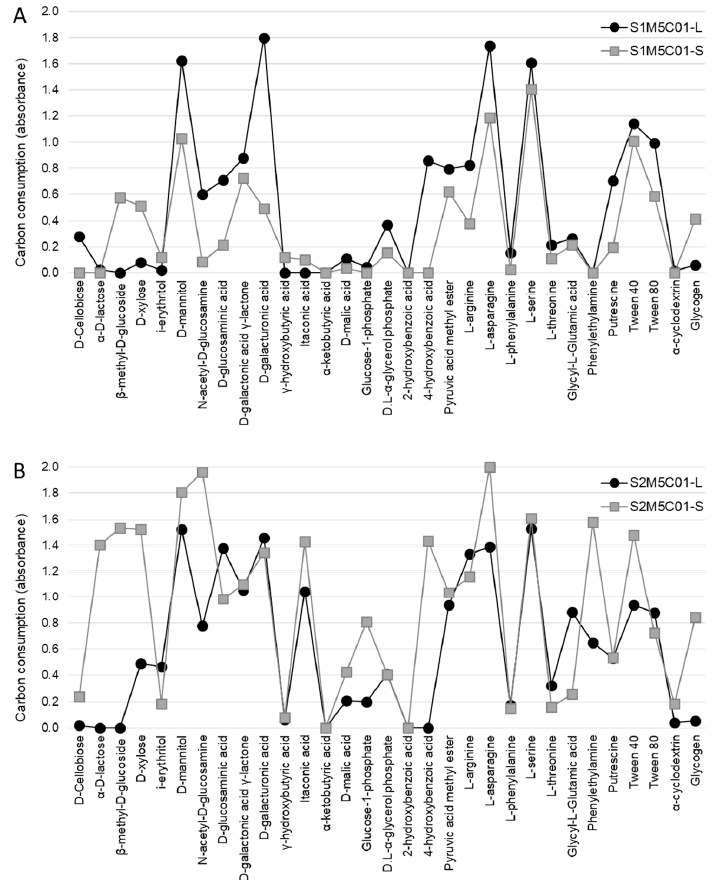
Figure 3. Metabolic profiles of M5C01. Consumption of the 31 carbon-sources by the lichen (-L) and substrate (-S) microbiotas associated with the symbiotic pair composed of the mycobiont haplotype M5 and the cyanobiont C01 haplotype from both sampling sites: S1 ( A ) and S2 ( B ).